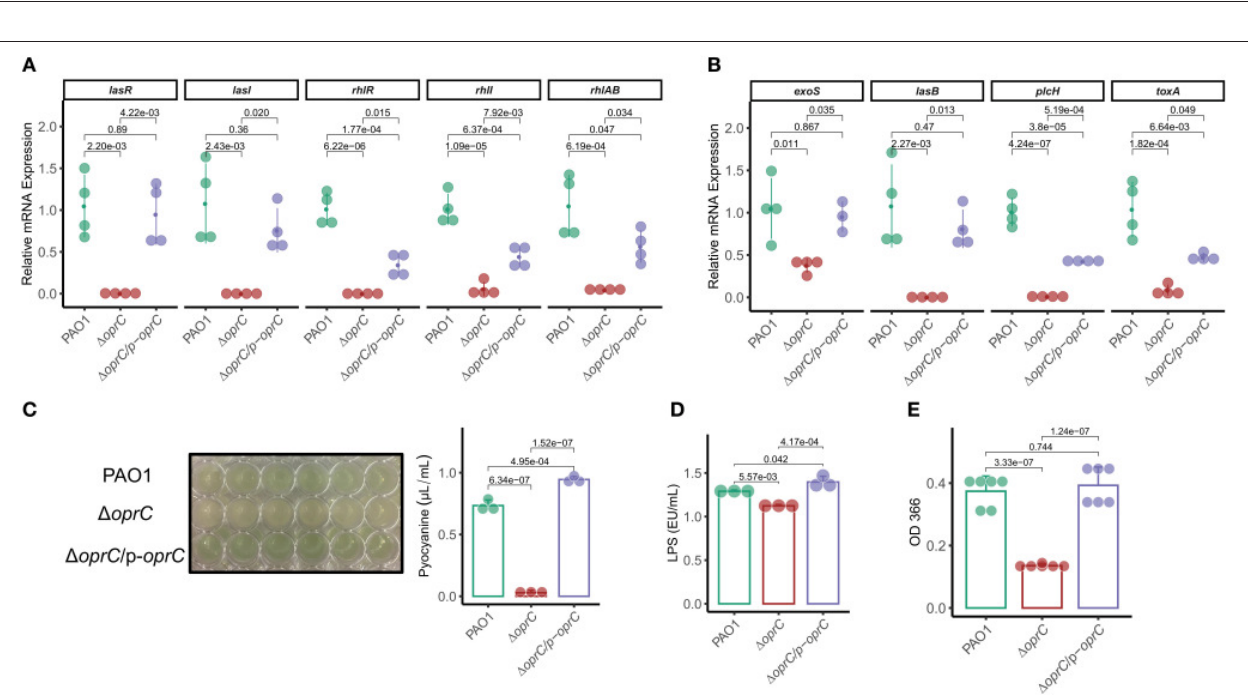
FIGURE 2 | 1 oprC exhibited increased toxin production and upregulated virulence-related gene expression. (A,B) The expression levels of quorum-sensing and virulence genes were assessed by qRT-PCR ( n = 3–4). (C) Quantification of pyocyanin production in P. aeruginosa ( n = 3). (D) Quantification of LPS production in P. aeruginosa ( n = 3). (E) Exoproteases activity of bacteria determined by the azocasein assay ( n = 6). Error bars represent the mean ± s.d. One-way ANOVA with a post-hoc Tukey test was performed for comparison of means of groups.